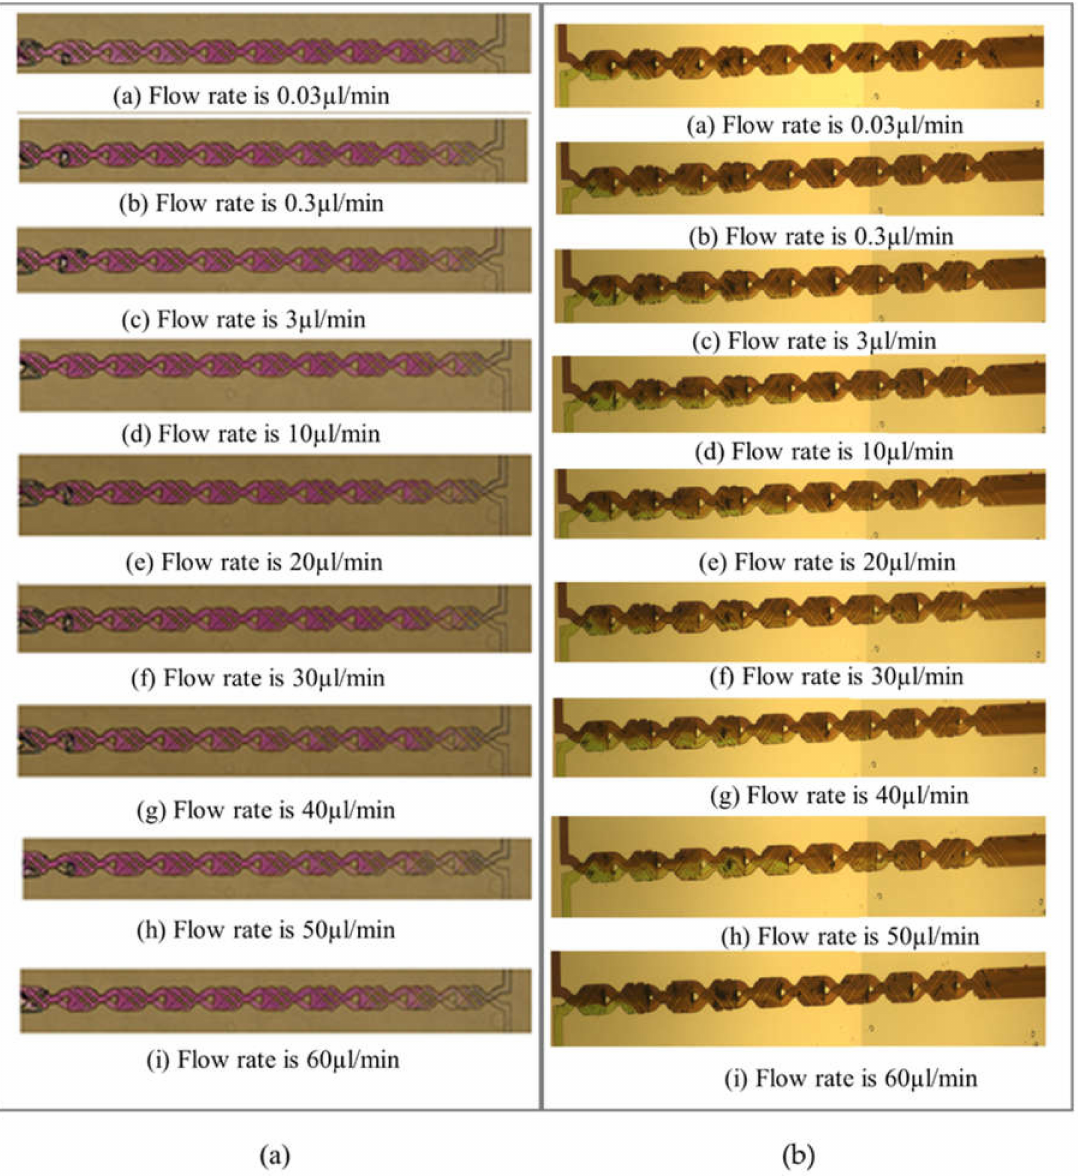
Figure 7. Experimental results of mixing performance of ( a ) phenolphthalein-NaOH and ( b ) purple–green dye at various flow